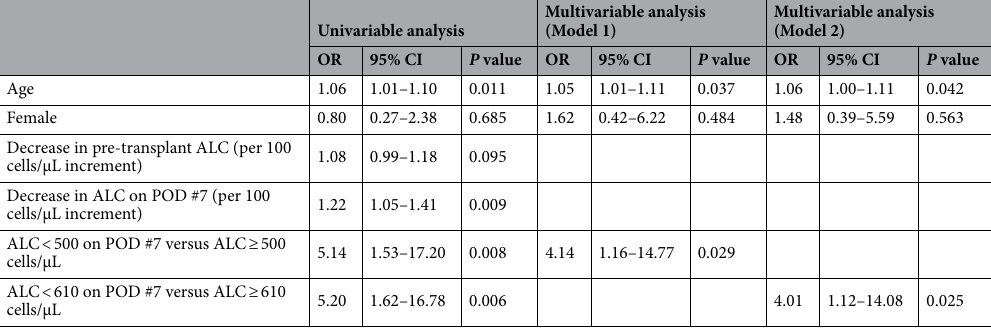
Table 3. Univariable and multivariable logistic regression analysis of risk factors for early CMV infection within 1 month of heart transplantation. ALC = absolute lymphocyte count, CI = confidence interval, CMV = cytomegalovirus, OR = odds ratio, POD = postoperative